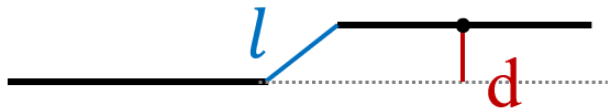
Figure 6. Point-line distance between two line segments.